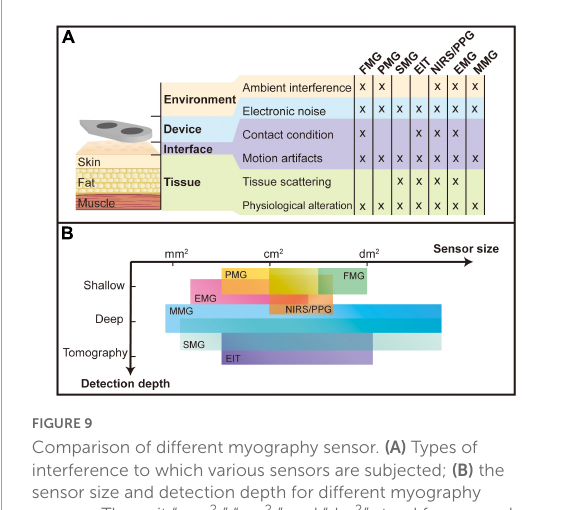
FIGURE9 Comparison of different myography sensor. (A) Types of interference to which various sensors are subjected; (B) the sensor size and detection depth for different myography sensors. The unit “mm 2 ,” “cm 2 ,” and “dm 2 ” stand for squared millimeter (10 - 6 m 2 ), squared centimeter (10 - 4 m 2 ), and squared decimeter (10 - 2 m 2 ),